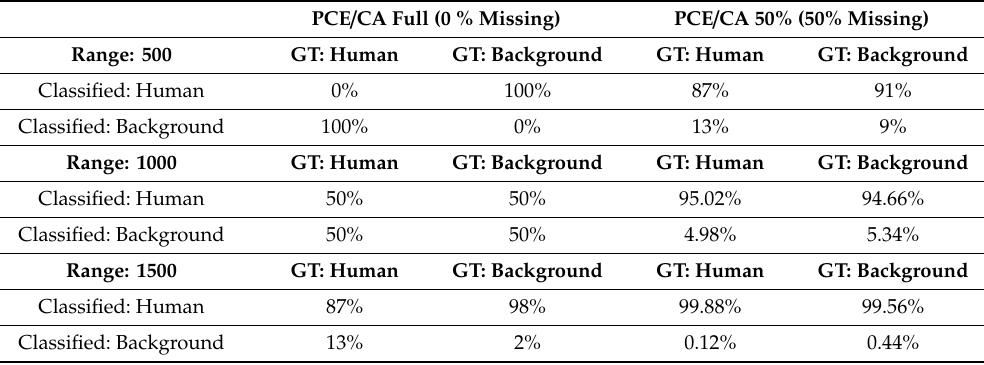
Table 2. ResNet confirmation results for optical videos using PCE. There were six confusion matrices. GT stands for ground